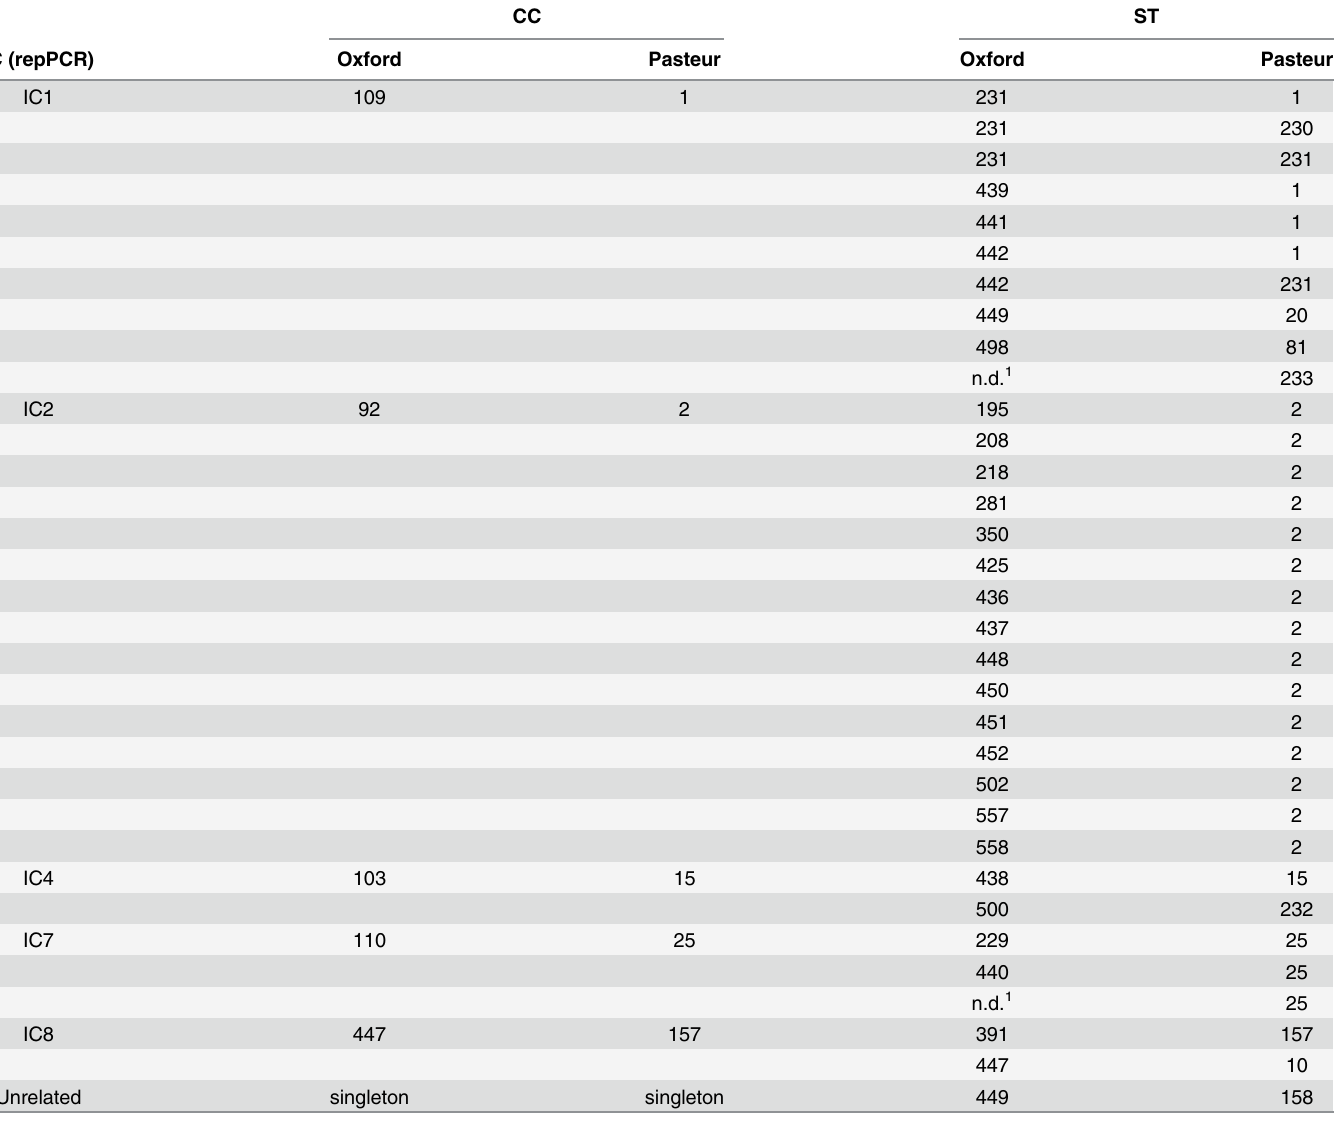
Table 2. International clones and corresponding CCs and STs of both MLST schemes based on the investigation of 99 A . baumannii outbreak and sporadic strains. CC ST IC